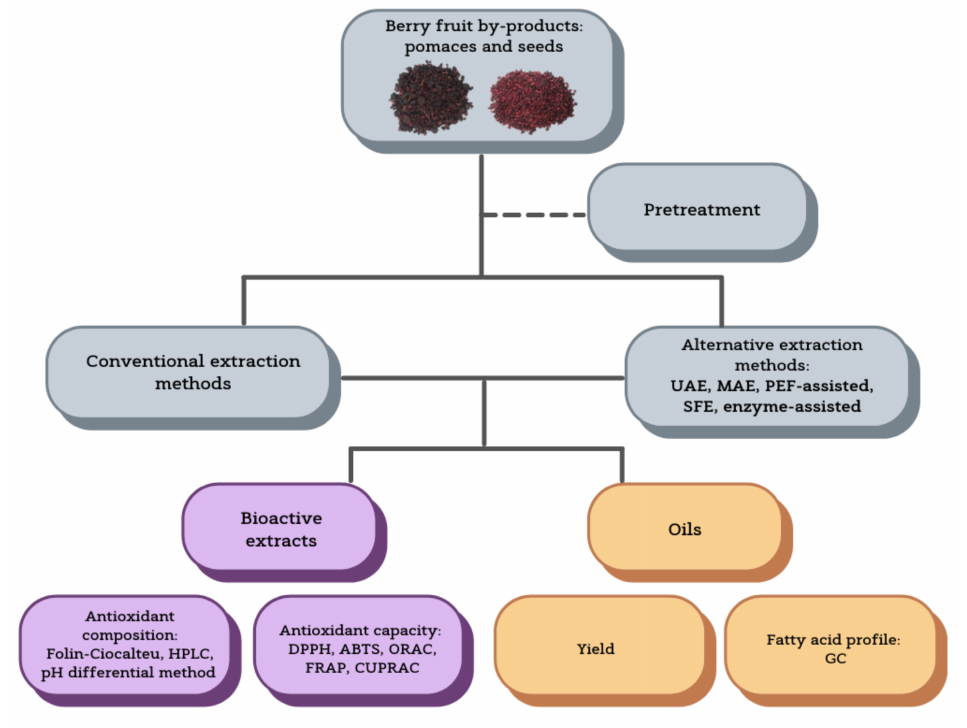
Figure 2. A scheme for the extraction procedures for bioactive compounds and oils from berry fruit